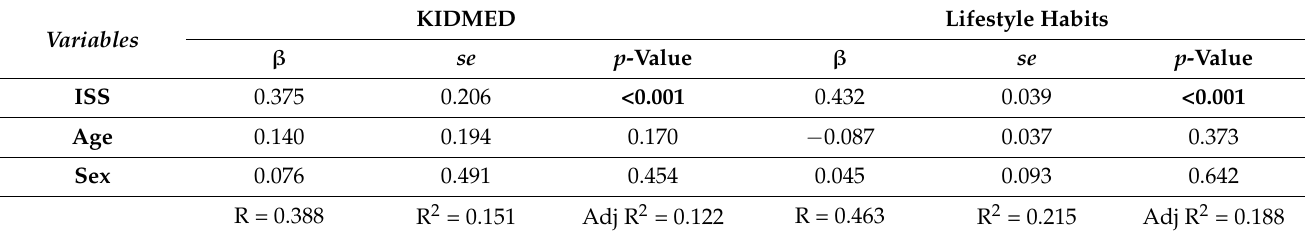
Table 2. Multiple linear regression analysis between KIDMED as well as lifestyle habits and a set of different